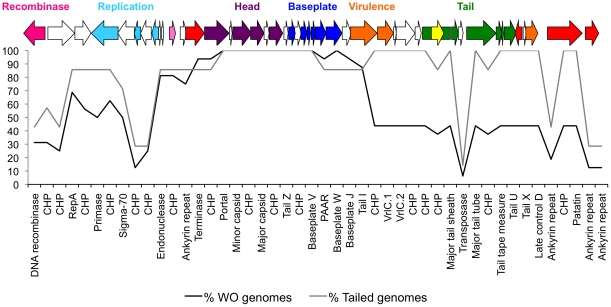
The core genome of prophage WO consists only of head and baseplate genes.The percentage of prophage WO genomes (N = 16) containing genes present in the active phage genome, WOCauB2, is depicted. Percentages were calculated for both all WO genomes (black) and only WO genomes with tail genes (grey). A gene map of WOCauB2 is shown above the plot with colors corresponding to the labels in Figure 1.